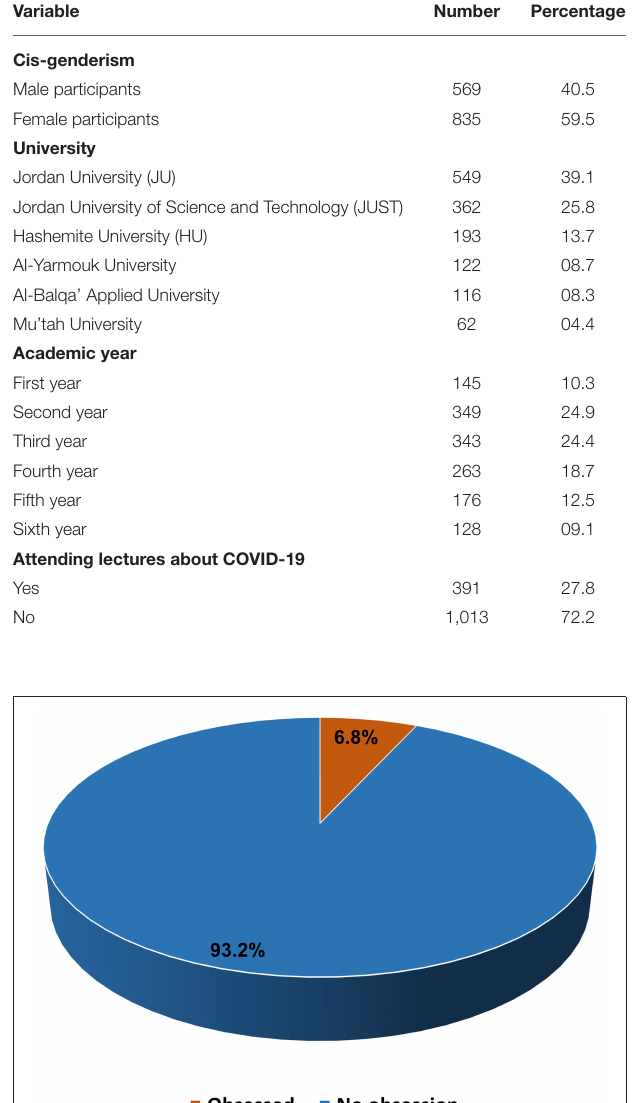
TABLE 1 | Socio-demographic characteristics of participated medical students ( n = 1,404).